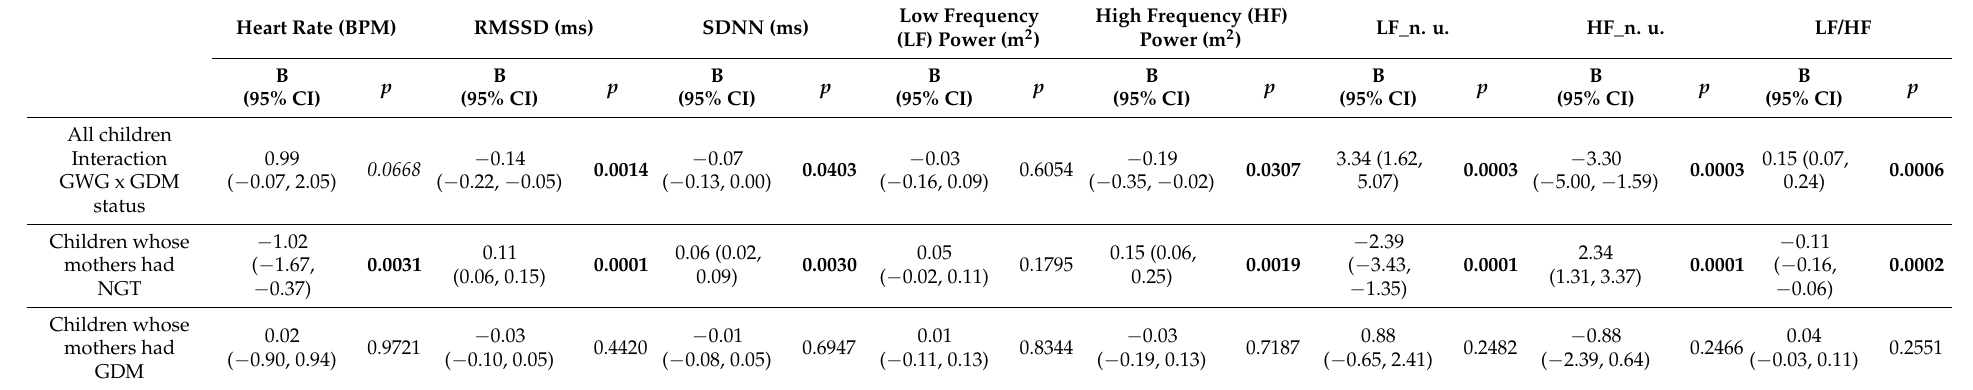
Table 2. Association of total gestational weight gain with heart rate variability and heart rate in 2-year-old children of mothers with and without